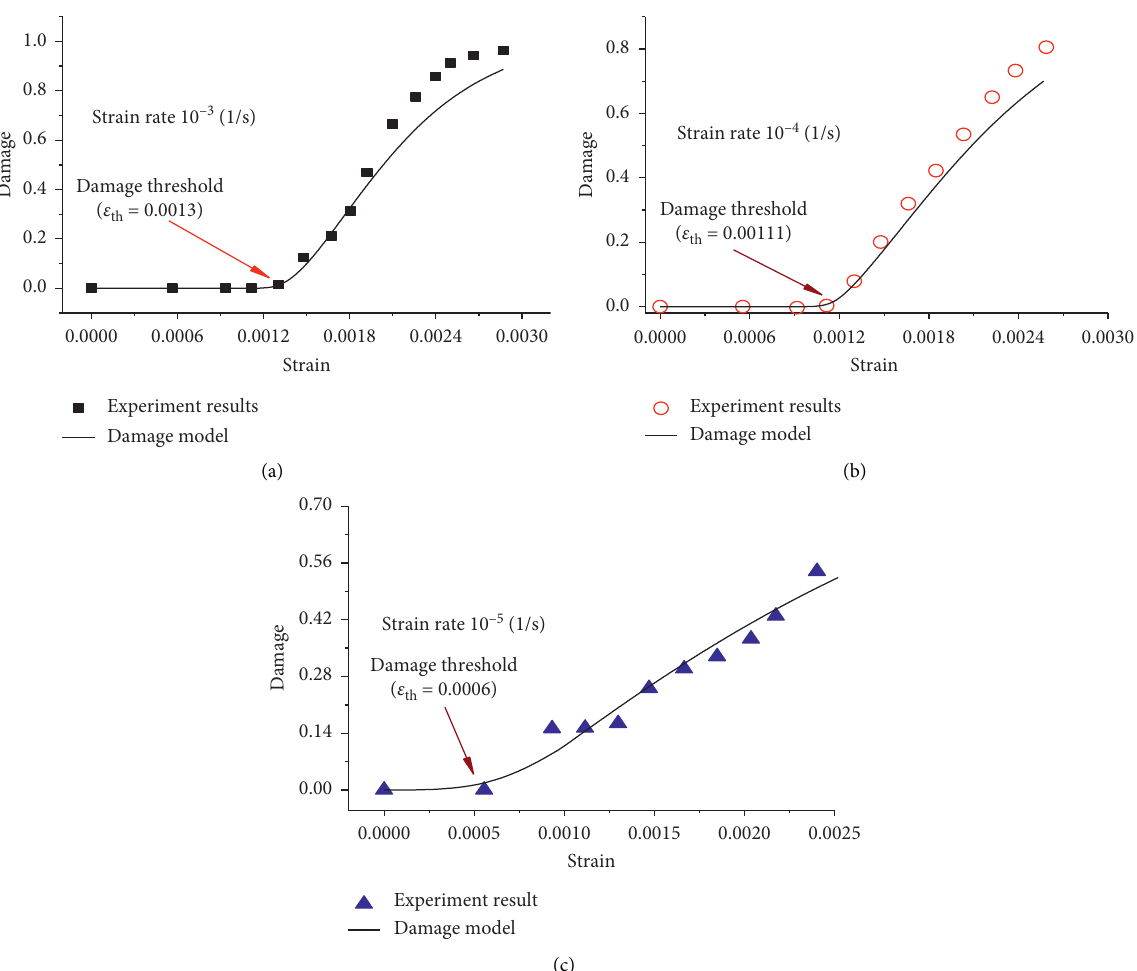
Figure 5: Experimental and model results of damage evolution in concrete under different strain